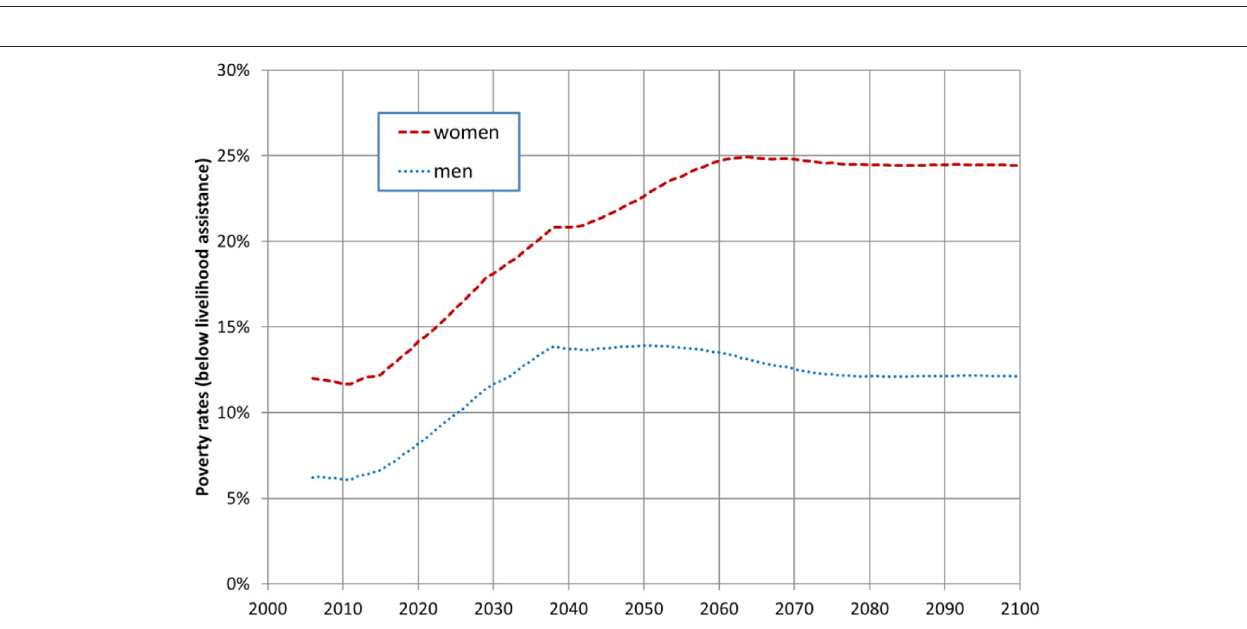
FIGURE 9 | Trends in poverty rates by gender. Simulation